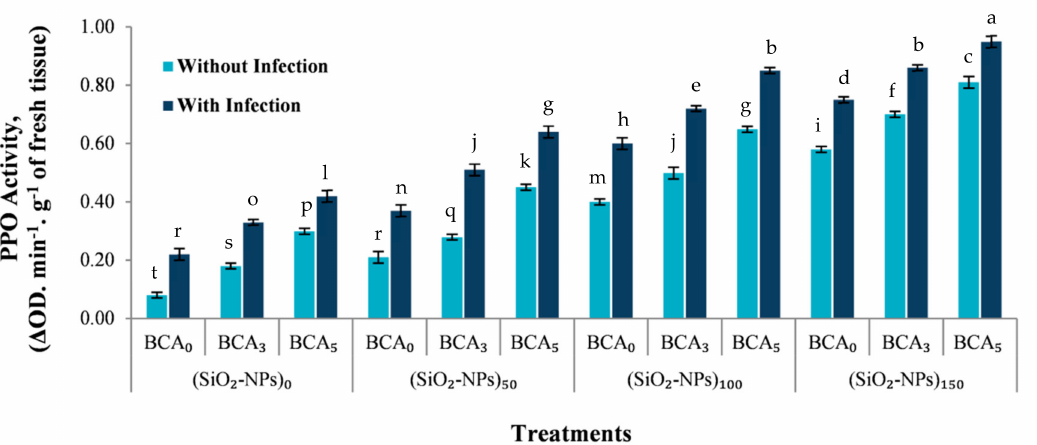
Figure 6. Polyphenol oxidase (PPO) activity, (change in absorbance min − 1 g − 1 of fresh tissue), of sweet pepper leaves as influenced by different treatments of SiO 2 -NPs (ppm), and BCA (%) without and with bacterial infection. Error bars represent the mean ± SD of the data of 5 replications. Different letter(s) above the error bars indicate statistically significant differences at ( p ≤ 0.05). Table 3. Leaf chemical composition (%) of sweet pepper plants as affected by different treatments of SiO 2 -NPs (ppm) and BCA (%) without and with bacterial leaf spot (BLS) infection. Treatments